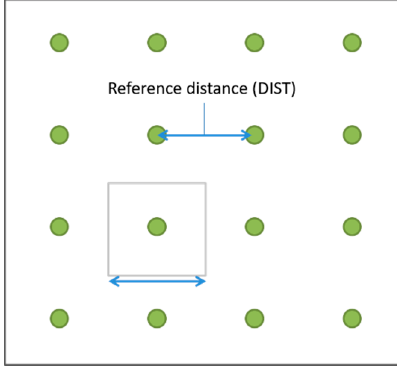
Figure 2. Stand geometry based on the mean distance between trees considering a squared grid.